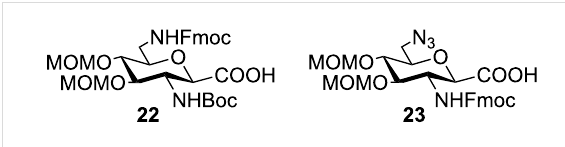
dictated by internal 10-membered hydrogen bonded rings. Such